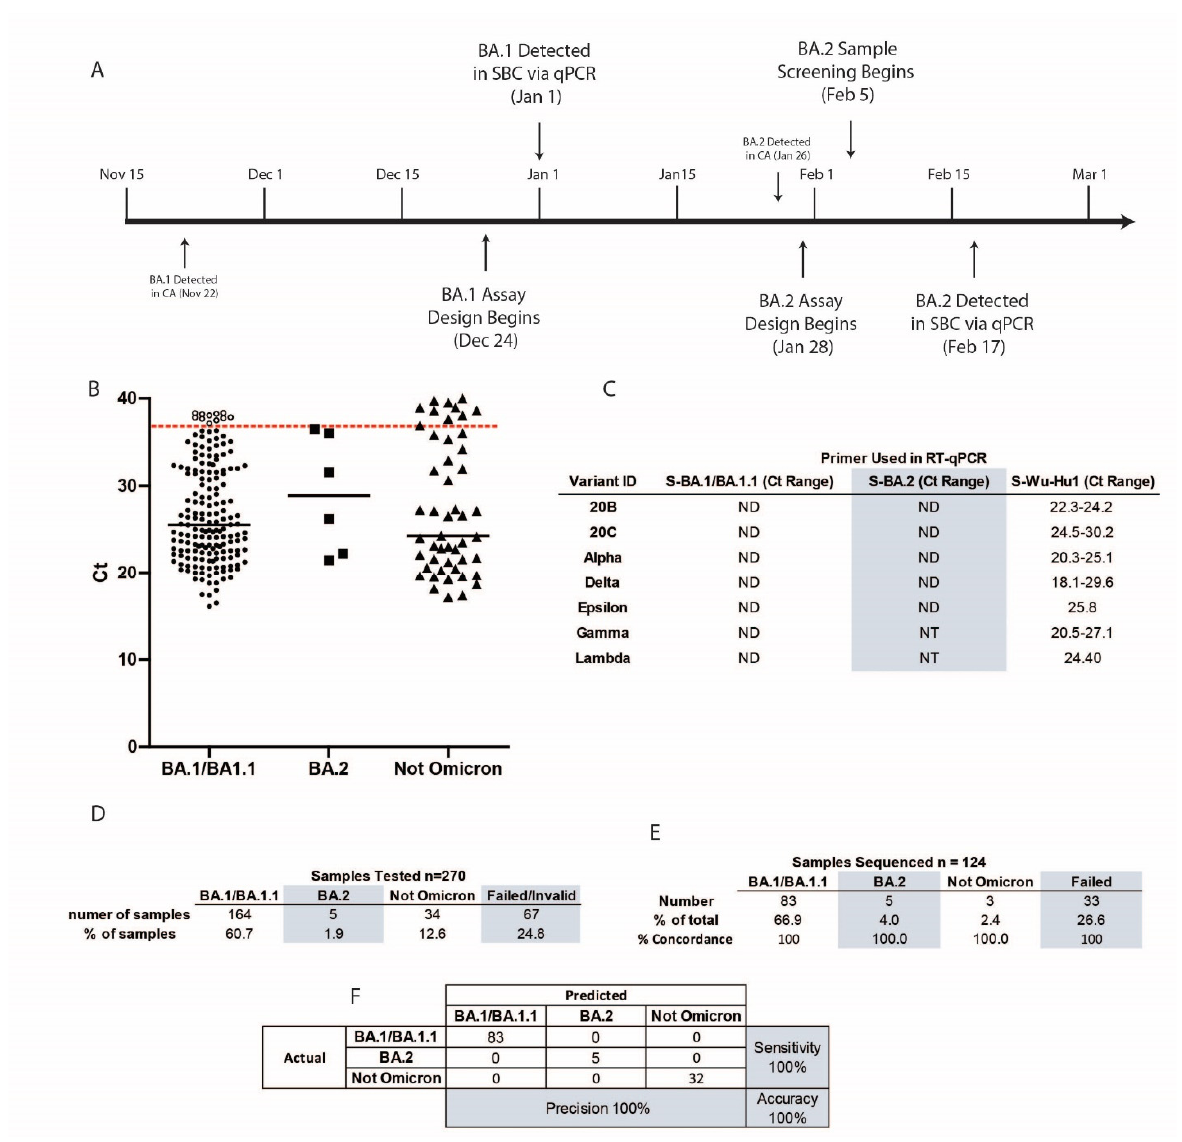
Figure 2. Design timeline and metrics of the Omicron variant-specific RT-qPCR. ( A ) Timeline of events around the design, optimization, and implementation of the Omicron variant-specific RT-qPCR in Santa Barbara County. ( B ) Ct values for all samples tested. The red dashed line indicates the cutoff at a Ct of 37. ( C ) Ct values of a panel of samples known to be variants other than Omicron BA.1, BA.1.1, and BA.2. ( D ) Results of all 270 samples tested. ( E ) Percent concordance and ( F ) confusion matrix of samples with whole viral NGS and variant-specific RT-qPCR data. ND: not detected; NT: not tested.